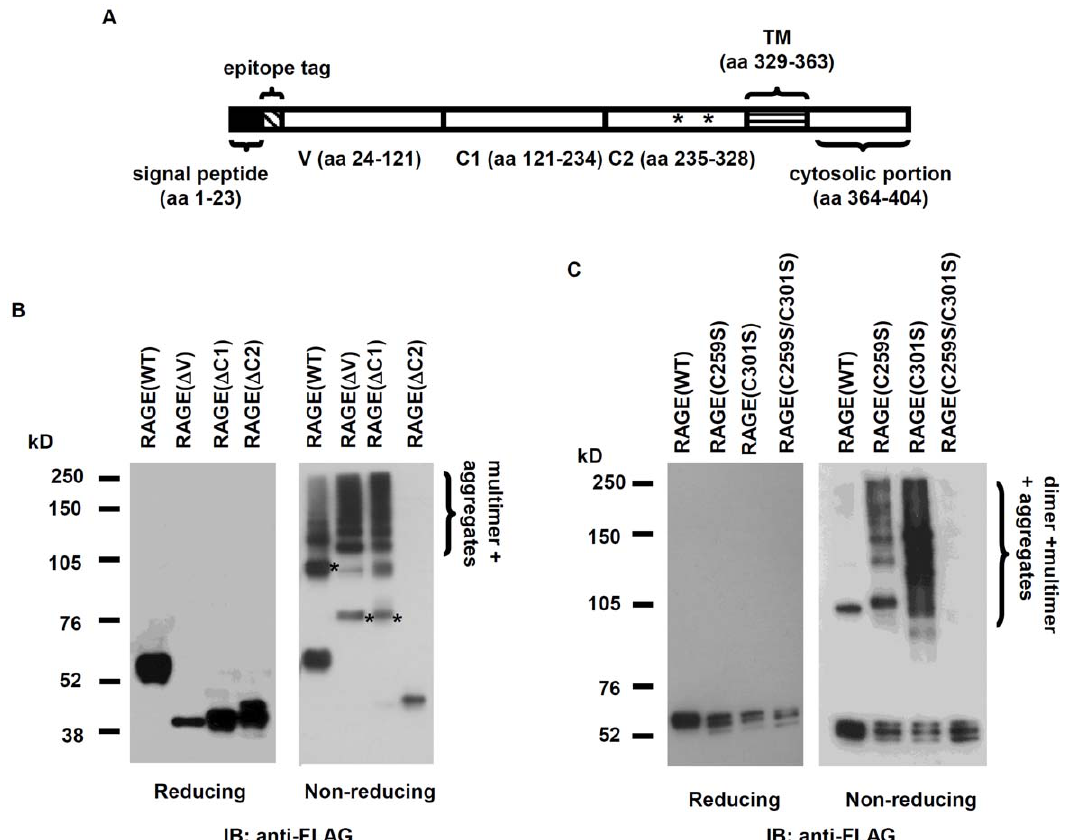
Figure 2. Intermolecular disulfide bonds contribute to the formation of RAGE dimers. ( A ) Schematic drawing of RAGE domains. aa: amino acids; * indicates C 259 and C 301 ; TM: transmembrane helix. ( B ) Identification of RAGE domain that is responsible for covalent-linked dimerization. About 5 m g of total membrane extracts was loaded. * indicate dimers of RAGE (WT) and deletion mutants. ( C ) RAGe C2 domain exhibits disulfide bond-mediated dimerization. * indicate dimers of RAGE(WT) and RAGE(C2). ( D ) Testing whether C 259 and C 301 are responsible for covalent-linked dimerization of RAGE. About 7.5 m g of total membrane extracts was loaded.